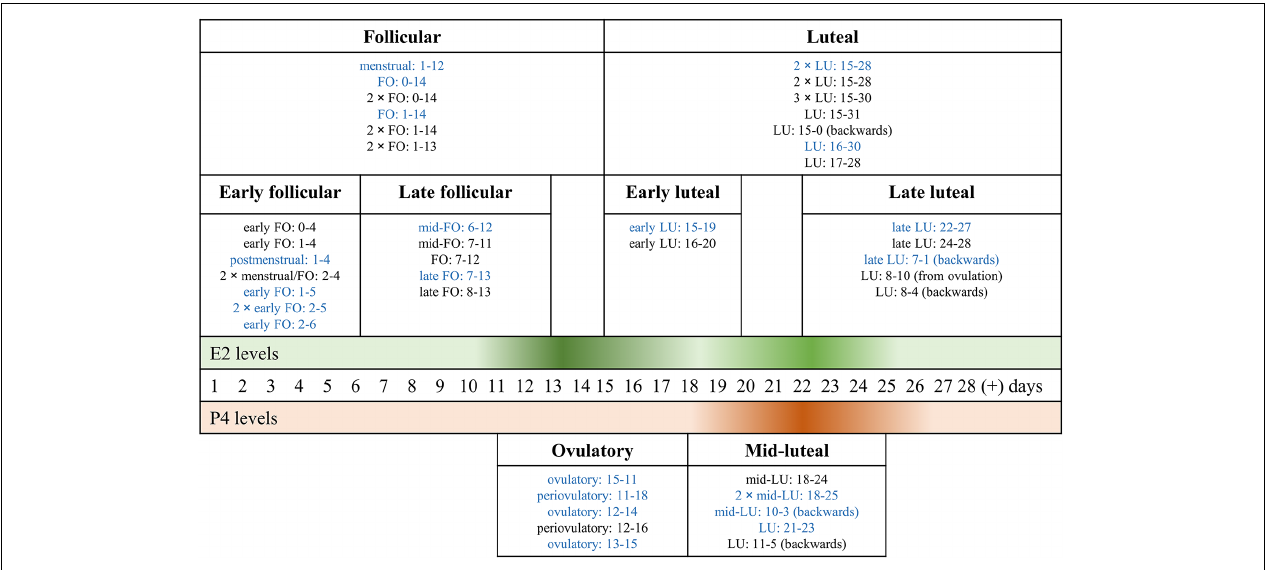
FIGURE 3 | Classification of the definition of cycle phases across the reviewed menstrual cycle studies. The bold-face titles of the rectangular boxes show the labels we use throughout the review, to refer to phases of the menstrual cycle. The three horizontal stripes in the middle show the idealized 28 cycle days and the associated levels of 17 β -estradiol (E2, green) and progesterone (P4, orange). The color gradient signifies hormone levels, with the highest levels shown in the darkest color and the lowest in the lightest color. The boxes are arranged so that the width of a box reflects the menstrual cycle days included under the specific label and the associated hormone levels. Entries in each box (small font) reflect the individual studies we combined under the same label, with their specific cycle days and their own cycle-phase labels. E.g., 2 × LU: 15-28 in the “Luteal”-box implies that two studies labeled cycle days from 15 to 28 days as the luteal phase. The figure serves to illustrate the variety of labels and included cycle days for the follicular and the luteal phase. Abbreviations. E2 : 17 β -estradiol; FO : follicular; LU : luteal; P4 : progesterone. [number] × ... : number of studies using the referred labeling; blue print: emotion recognition studies; black print: emotional memory studies; (+): more than a 28-day